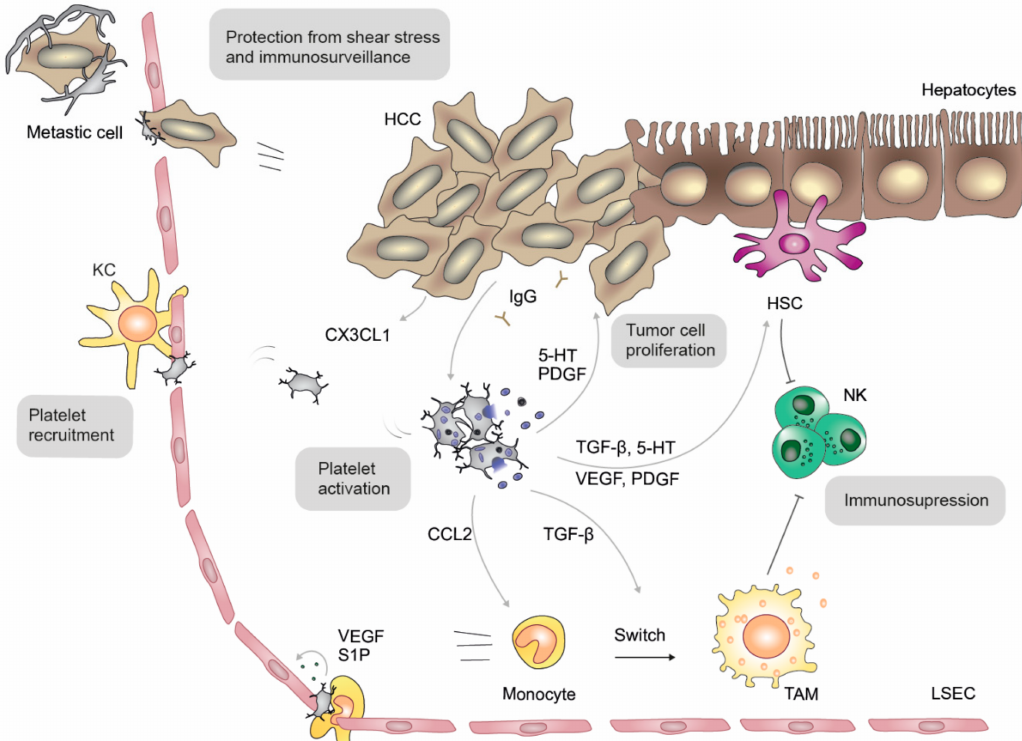
Figure 6. Platelets in hepatocellular carcinoma (HCC). During cancer progression, platelets are recruited by Kupffer cells (KC) and chemokine (C-X3-C motif) ligand (CX3CL1) release from cancer cells and subsequently become activated in the tumor environment (e.g., by immunoglobulins [Ig]). The release of their granule content promotes tumor cell proliferation and the activation of hepatic stellate cells (HSC). Moreover, the interaction with liver sinusoidal endothelial cells (LSEC) promotes tumor angiogenesis and facilitates the infiltration of leukocytes, which eventually develop into tumor-associated macrophages (TAM) that dampen immunosuppression by natural killer (NK) cells. Platelets promote tumor metastasis by protecting tumor cells from recognition by the immune system and from increased shear stress in various body fluids. Following mediators are involved: serotonin (5-HT), sphingosine-1-phosphate (S1P), platelet-derived growth factor (PDGF), transforming growth factor- β (TGF- β ), vascular endothelial growth factor (VEGF) and CC-chemokine ligand 2